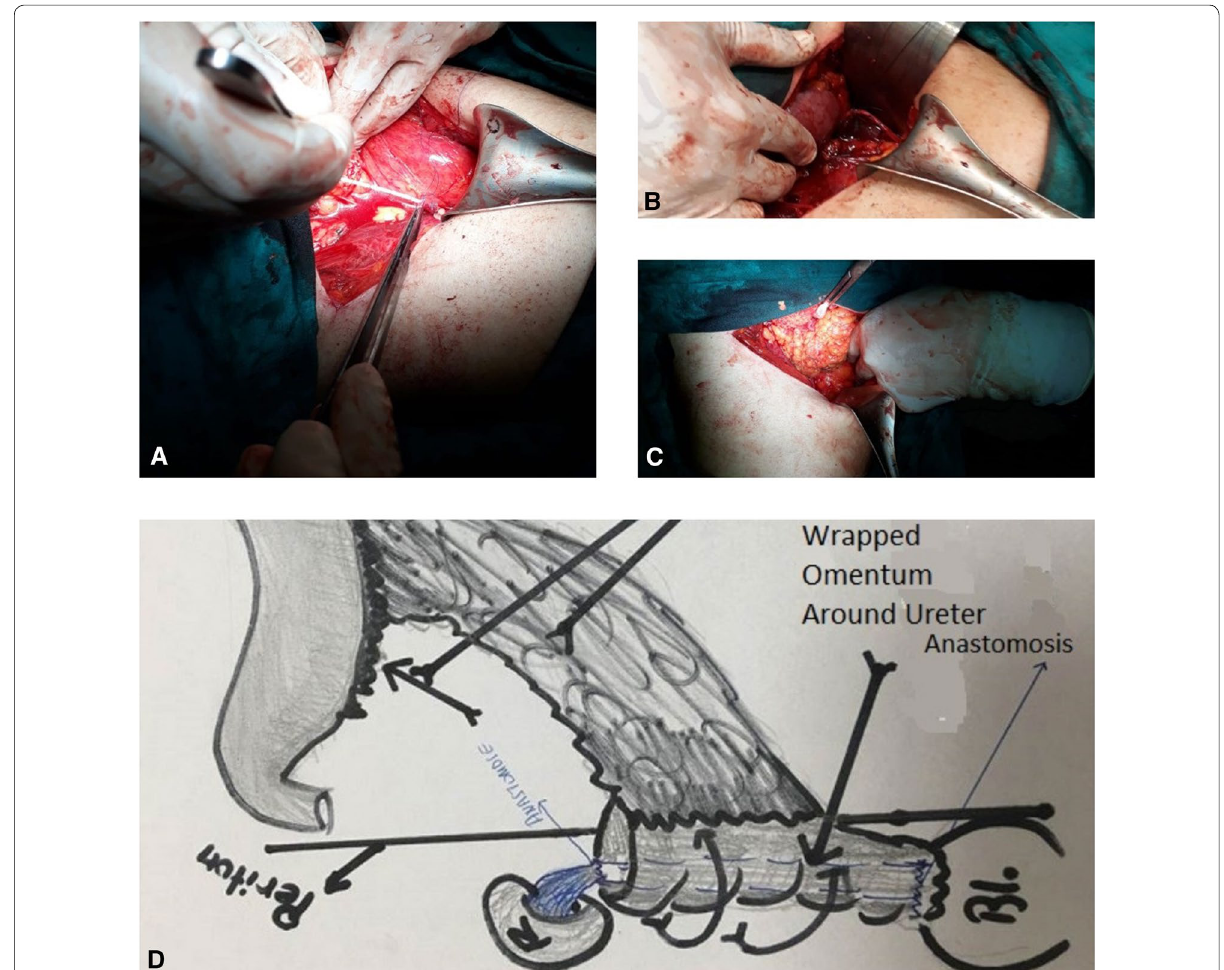
Fig. 1 Ureteral re-implantation technique. a Degloving ureter, b D-j stent in ureter that anastomosis between bladder and kidney, c omental flap, d omental flap